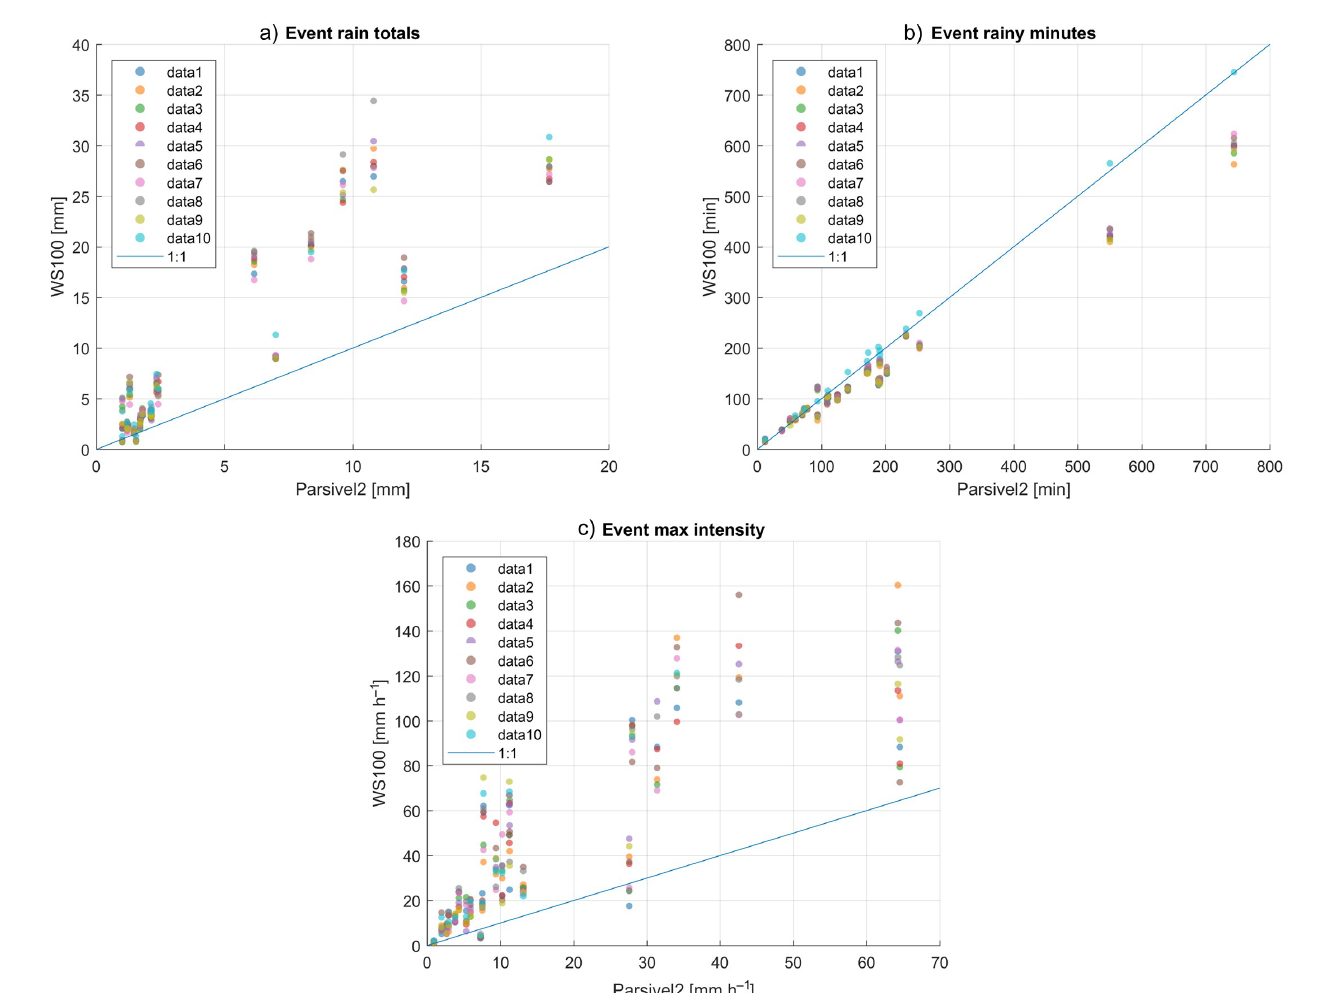
Figure 8. Comparison of ten WS100 sensors with Parsivel 2 in rainfall events: ( a ) Accumulated event rain totals greater than 1 mm. ( b ) Duration of each event in minutes. ( c ) Maximum intensity registered by each event. Parsivel 2 is used as reference and 23 events where found. The blue dashed line indicates the 1:1